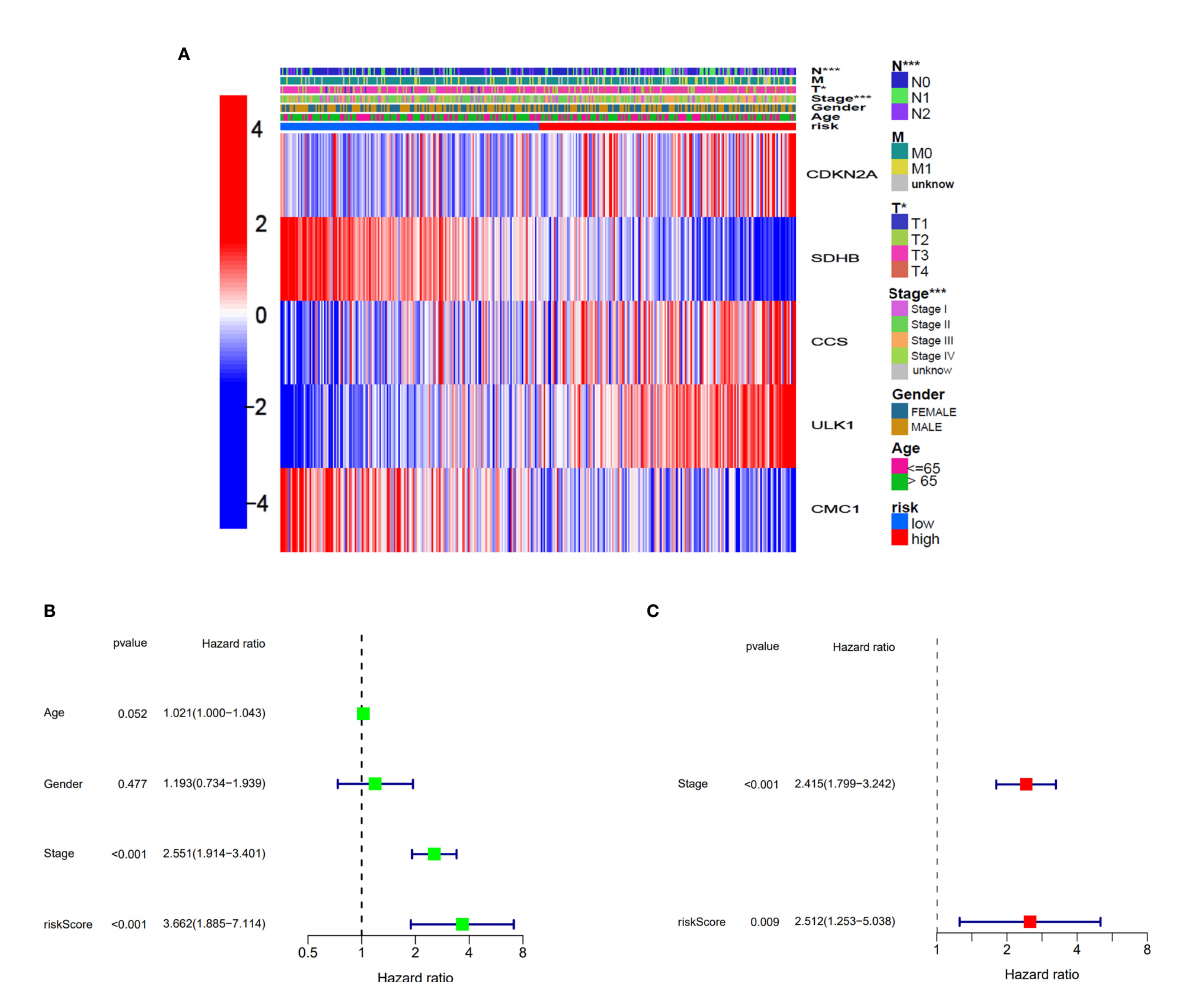
FIGURE 5 Univariate and multivariate Cox regression analyses for the risk score. (A) Heatmap for the connections between clinicopathological features and the risk groups. *p<0.05, ***p<0.001. (B) Univariate Cox analysis for the clinicopathological features and the risk score. (C) Multivariate Cox analysis for the clinicopathological features and the risk